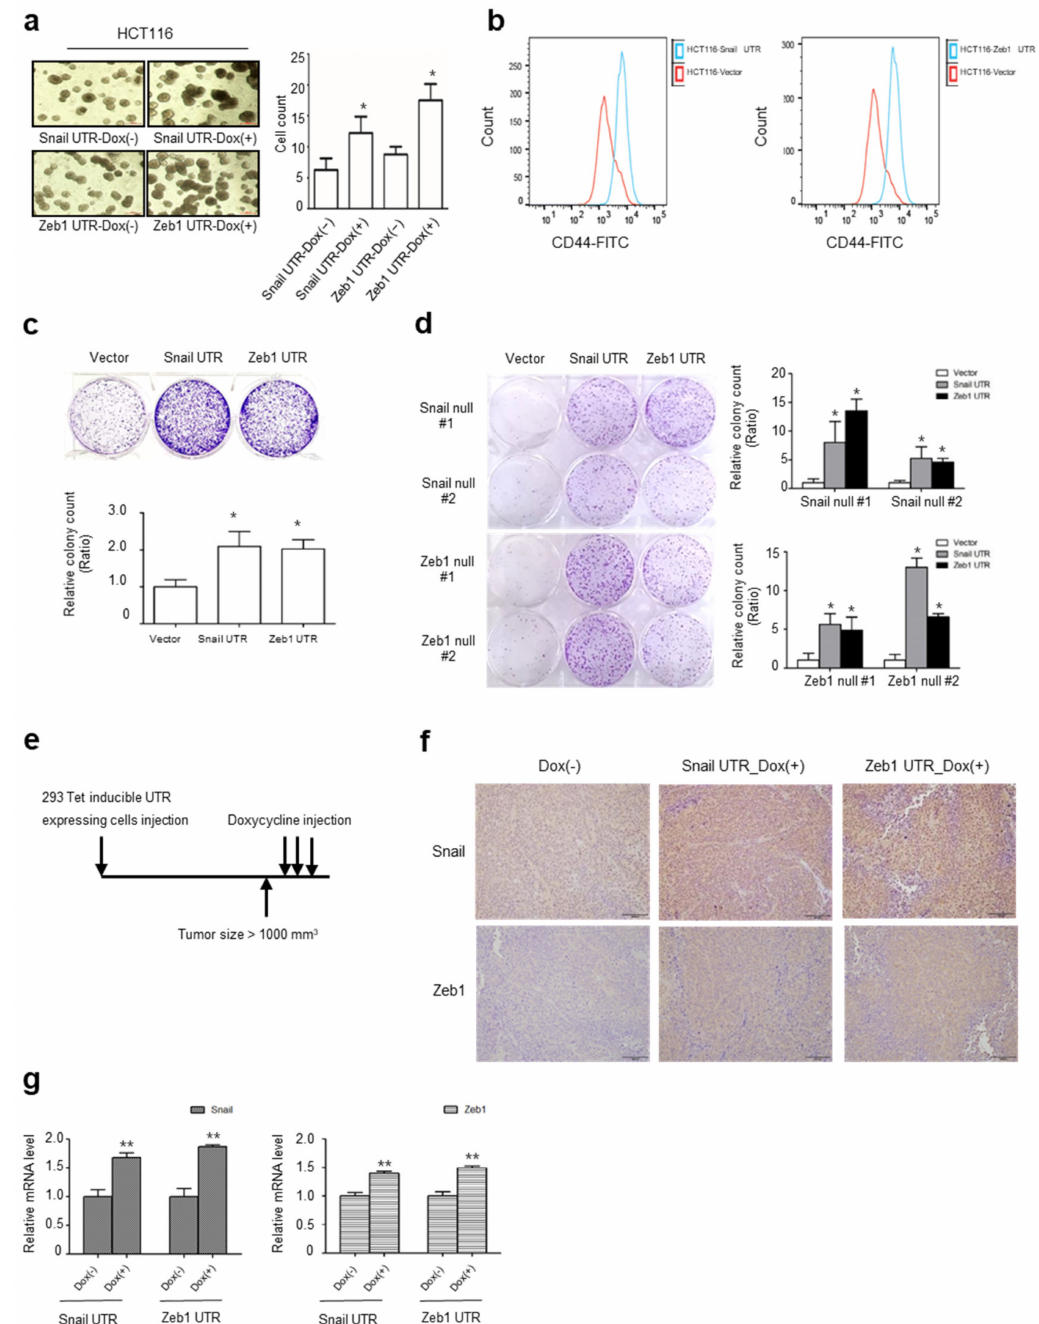
Figure 4. UTRs induce cancer stem cell phenotype and therapeutic resistance: ( a ) Representative images (left panel) and colony number (right panel) of UTR-expressing HCT116 cells grown in soft agarose. Cell lines were transduced with the Tet-inducible UTR expressing lentivirus, then treated with or without doxycycline (* p < 0.05 compared with control, Mann–Whitney test); ( b ) Flow cytometry analysis of CD44 protein in Snail UTR (left panel) or Zeb1 UTR (right panel) expressing HCT116 cells; ( c ) Clonogenic survival assay of HCT116 after transfection of Snail and Zeb1 UTR against 5 nM paclitaxel treatment (* p < 0.05 compared with control, Mann–Whitney test). Colonies of more than 50 cells were counted after crystal violet staining; ( d ) Clonogenic survival assay against paclitaxel treatment after transfection of UTR in Snail and Zeb1-knocked out HCT116 (* p < 0.05 compared with control, Mann–Whitney test); ( e ) Schematic diagram of experimental design in vivo. A doxycycline-inducible 293-UTR cell line was used. Once tumor size reached 1000 mm 3 , we induced UTR with administration of doxycycline (5 mpk) 3 times; ( f ) Snail and Zeb1 immunohistochemical staining; ( g ) Relative mRNA expression level of Snail and Zeb1 (** p < 0.01 compared with control, t